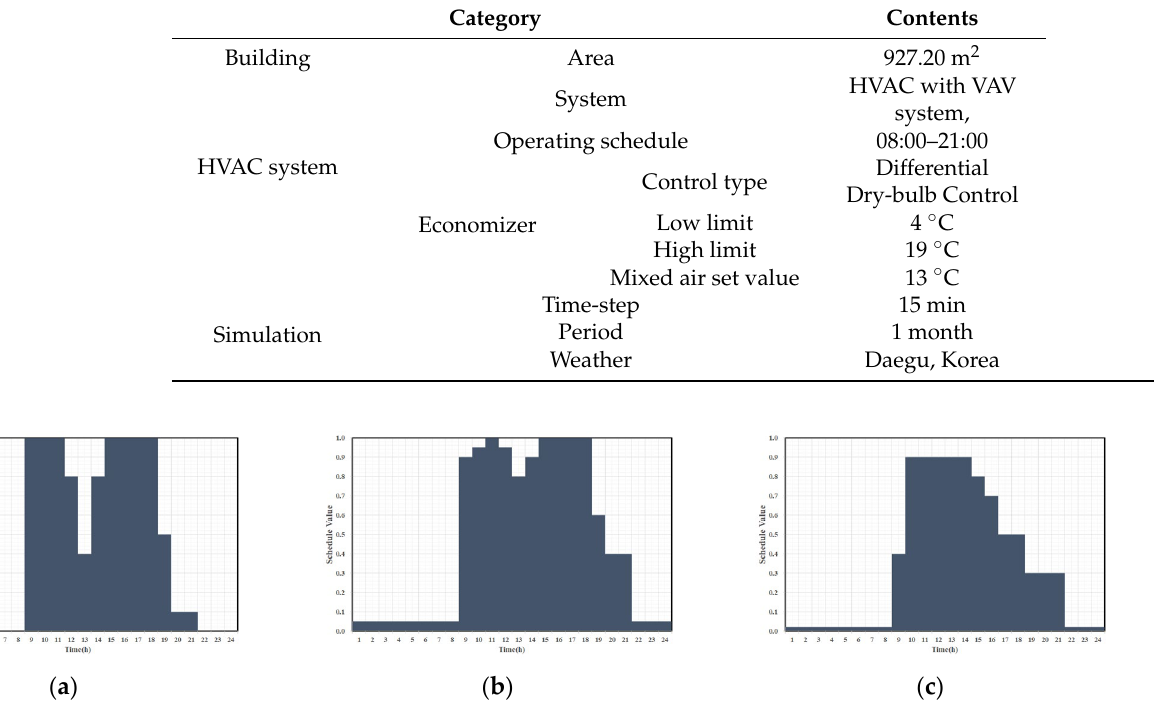
Table 3. Overview of the simulation.